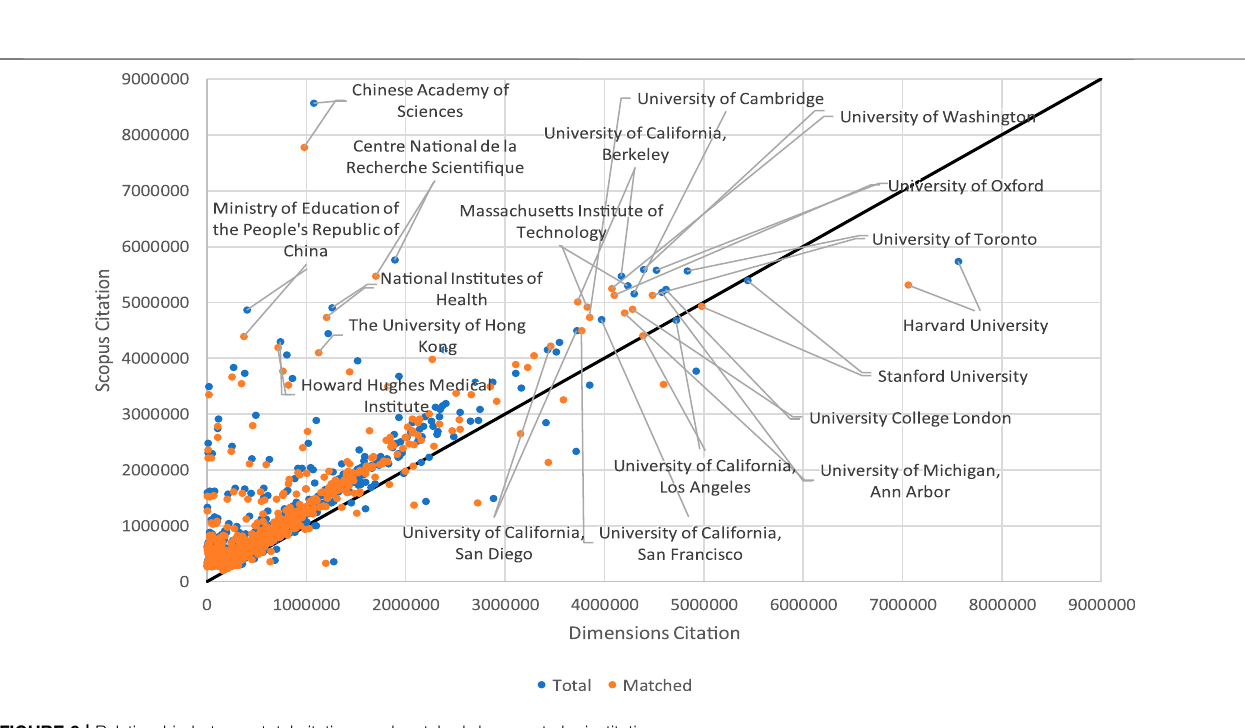
FIGURE 9 | Relationship between total citations and matched documents by